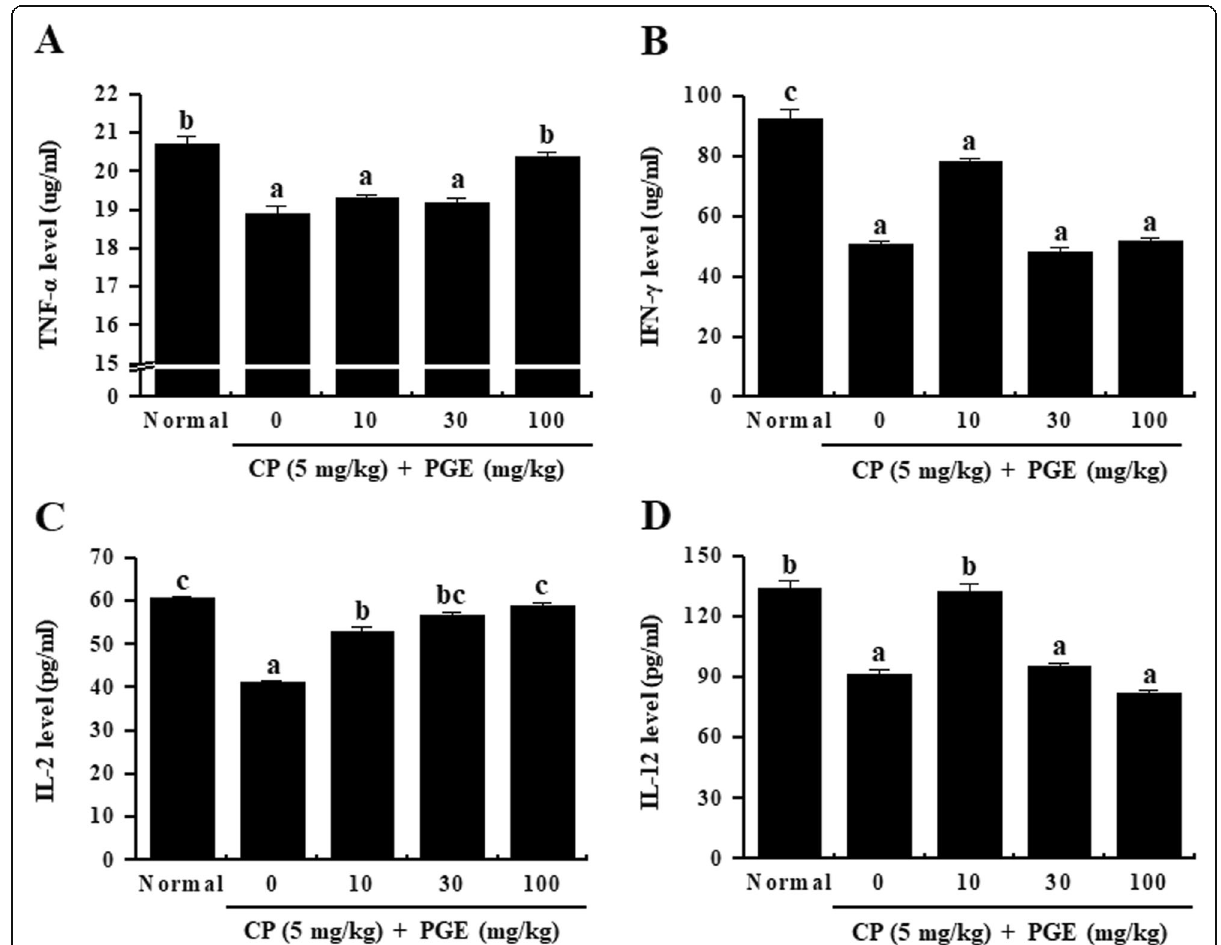
Fig. 7 Effect of PGE on the plasma levels of immune-related cytokines in the sera of CP-induced immunosuppression rats. Rats were given saline, CP (5 mg/kg/day), and PGE (0, 10, 30, or 100 mg/kg/day) once daily for 28 days, after which the serum levels of TNF- α ( a ), IFN- γ ( b ), IL-2 ( c ), and IL-12 ( d ) were quantified using ELISA kits. Bars labeled with different superscripts have significantly different values ( P < 0.05). Data are presented as the means ± standard errors ( n =